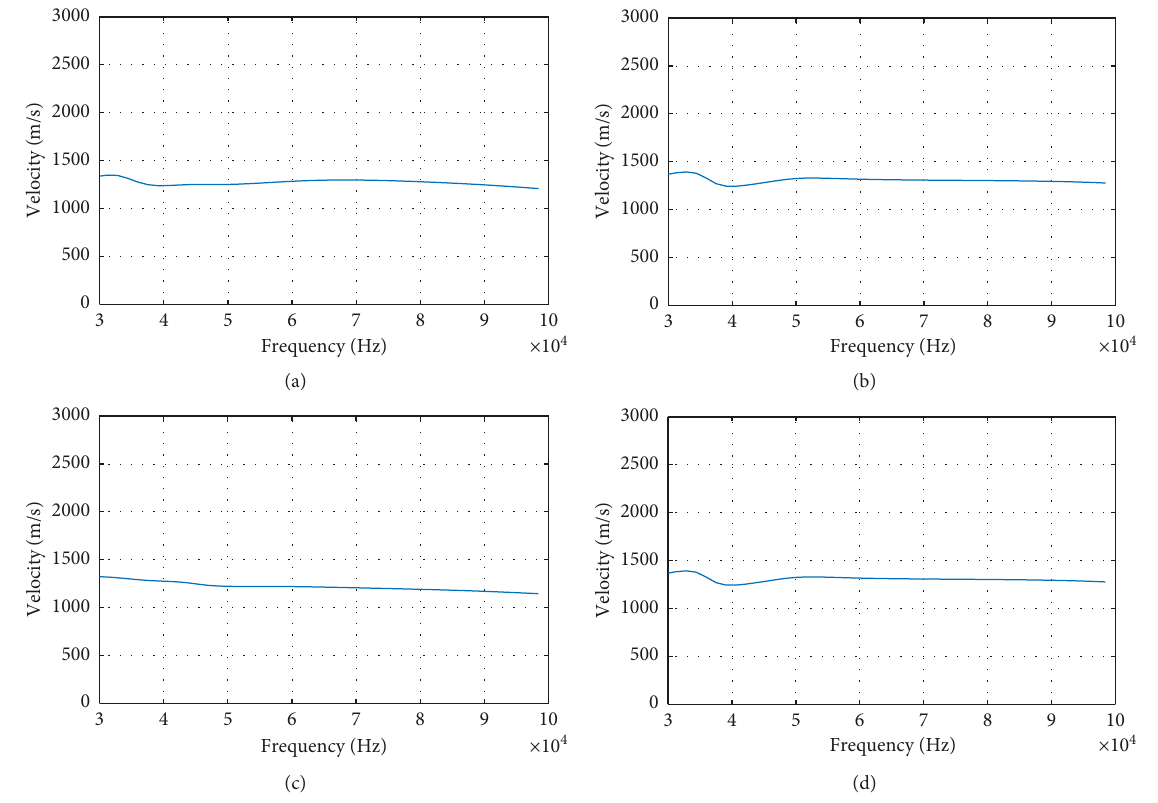
Figure 13: Frequency-dependent phase velocity of ultrasonic pulse in concrete: (a) square hole depth 100mm; (b) square hole depth 200mm; (c) square hole depth 300mm; (d) square hole depth